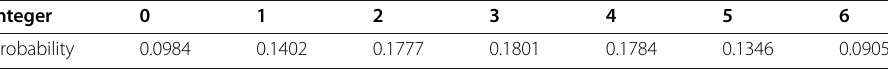
Table 5 The probability of modifying other integers to each specific integer for 16 × 16-sized CU in the modified EMD coding method Integer 0